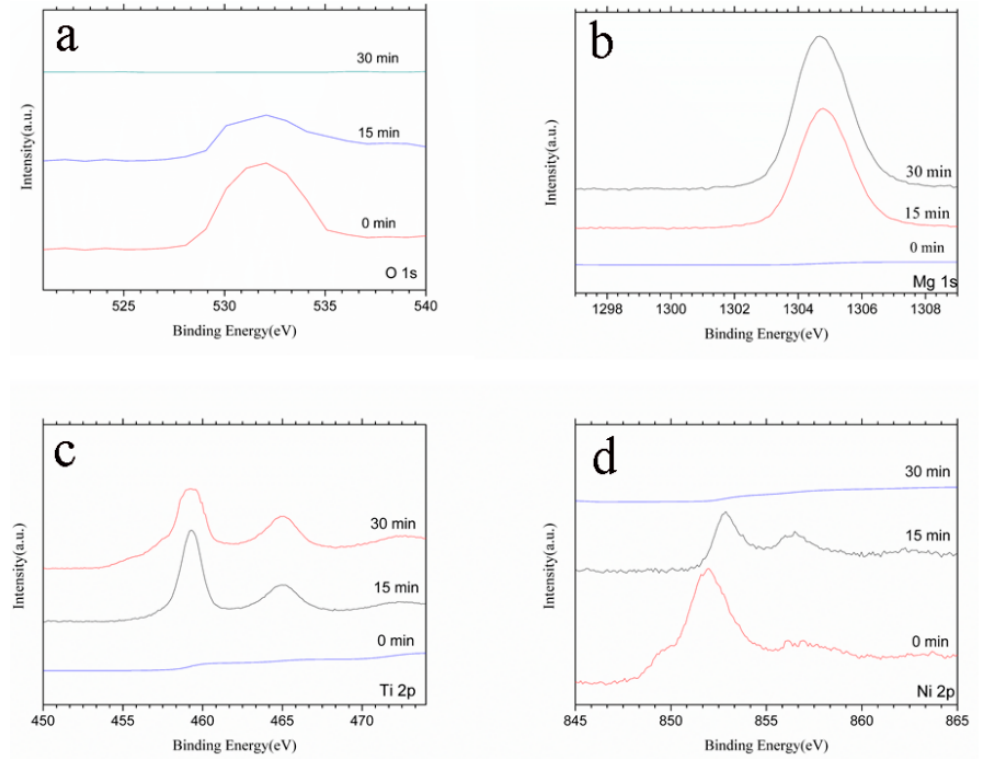
Figure 2. High-resolution XPS spectra of the treated AM60 alloy after various sputtering times: ( a ) O 1s, ( b ) Mg 1s, ( c ) Ti 2p, and ( d ) Ni 2p.